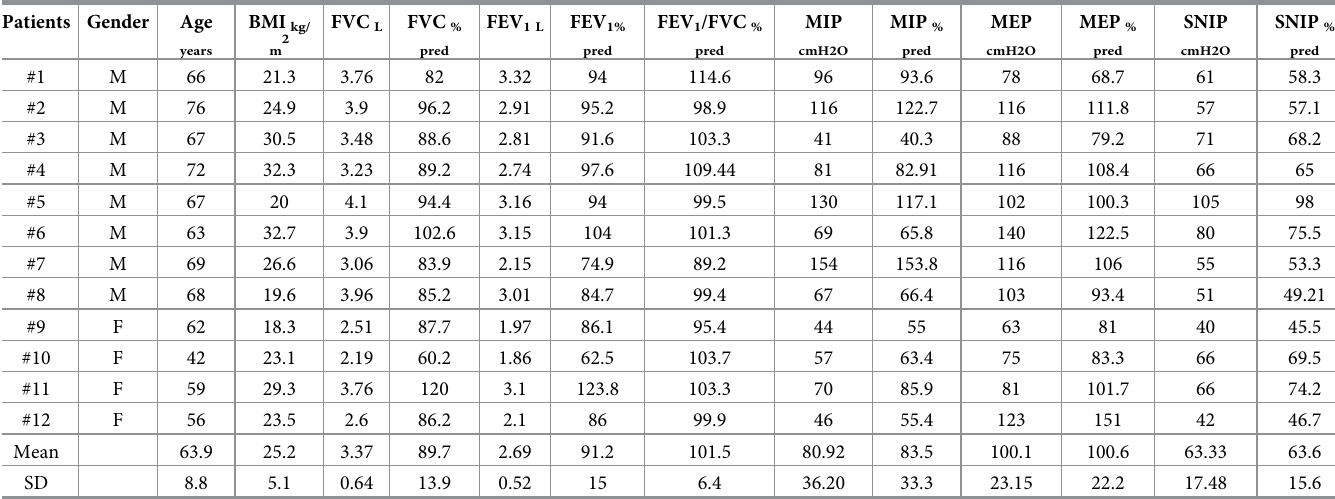
Table 1. Anthropometric and spirometric data. Patients